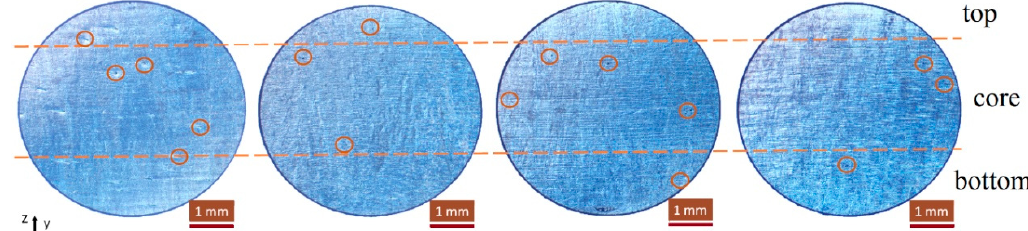
Figure 4. Porosity inspection in a–d samples under optical microscope (25 × ): circles denote largest observed pores.